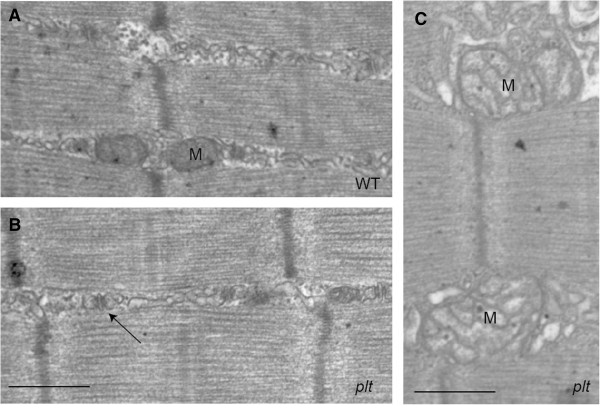
Ultrastructural analysis of pale tremor (plt) skeletal muscle. Representative photomicrographs from transmission electron microscopic analysis of wild-type/littermate (WT) quadriceps (A) and plt quadriceps (B) and (C). Muscle ultrastructure was generally normal in plt muscle (B) with evidence of normal triads (arrow). There were infrequently observed areas of abnormalities that particularly included swollen and/or dilated mitochondria (M in (C)). Scale bars = 500 nm.